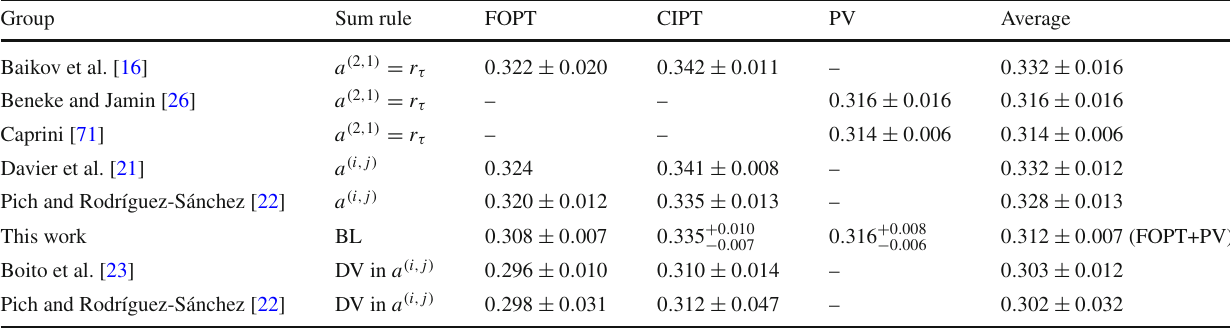
Table 6 The values of α s ( m 2 τ ) , extracted from ALEPH τ -decay data, as obtained by various groups applying sum rules and various methods. ’BL’ stands for (double-pinched) Borel Laplace, and ‘DV’ stands for a duality violation model